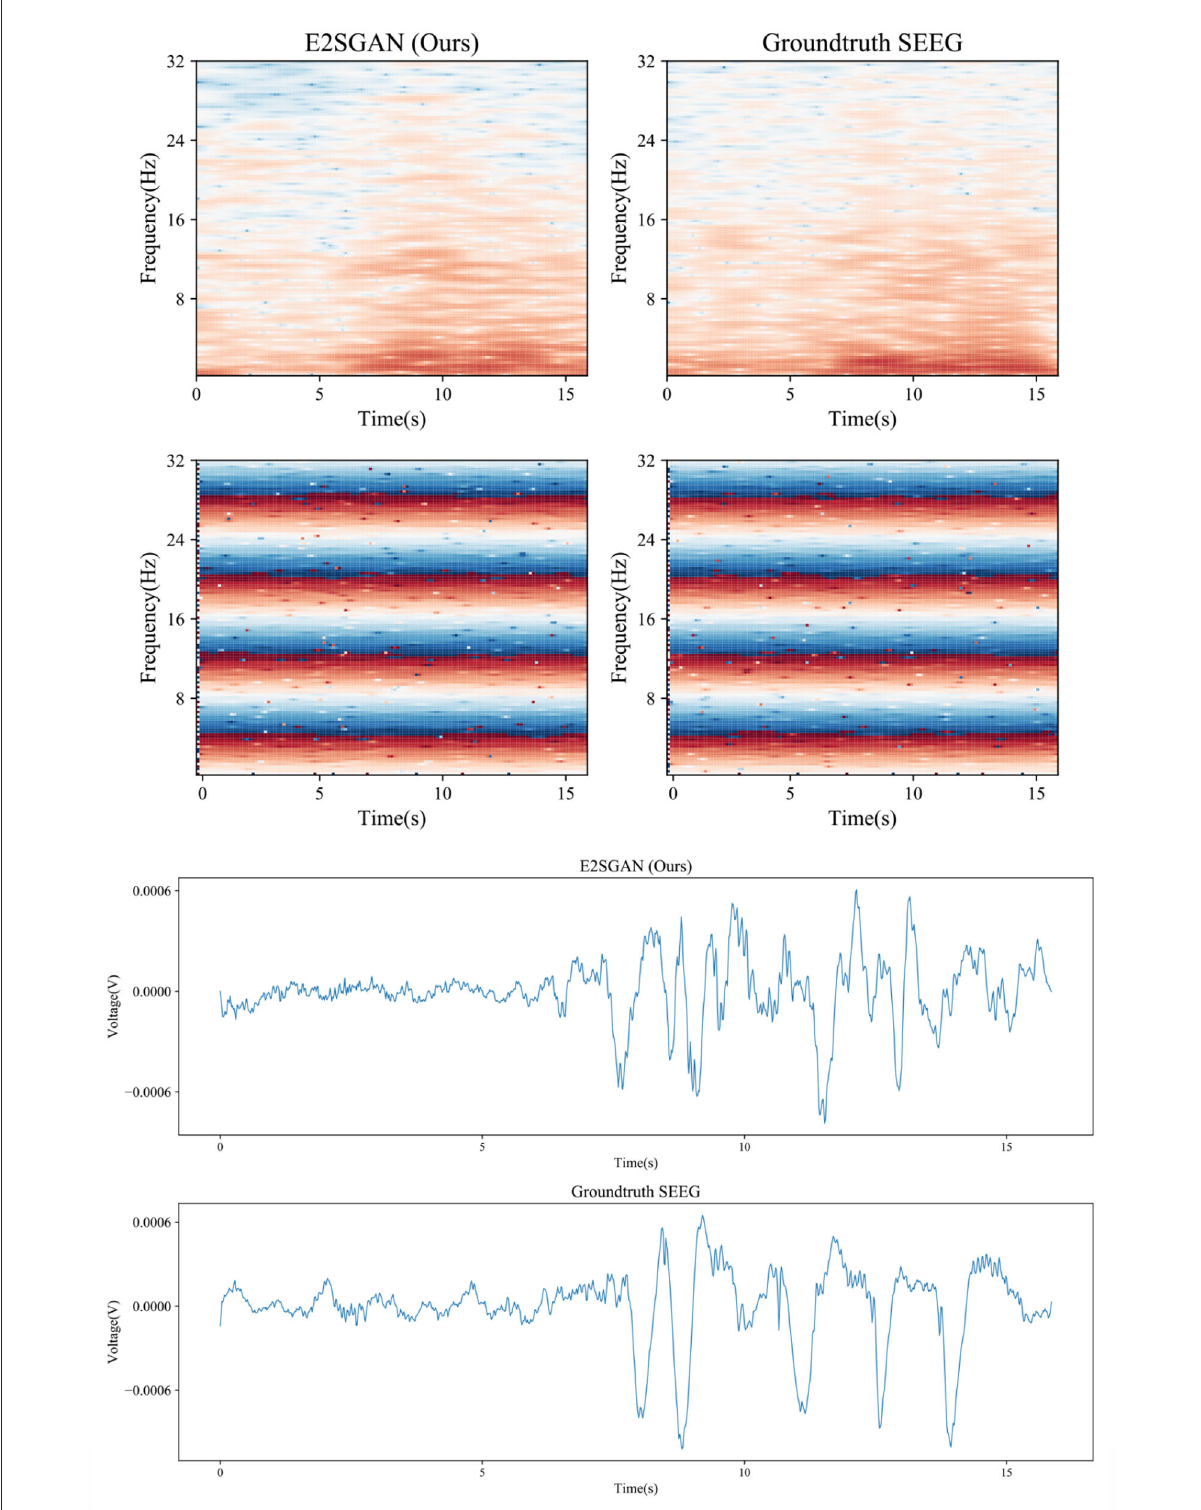
FIGURE7 Case study of spectral results (top) and temporal results (bottom) synthesized by the proposed method compared to the